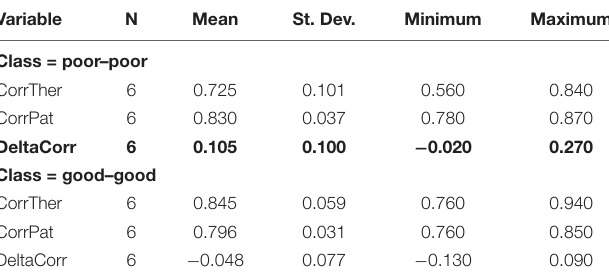
TABLE 3 | Means and standard deviations of DeltaCorr across different outcome classes.